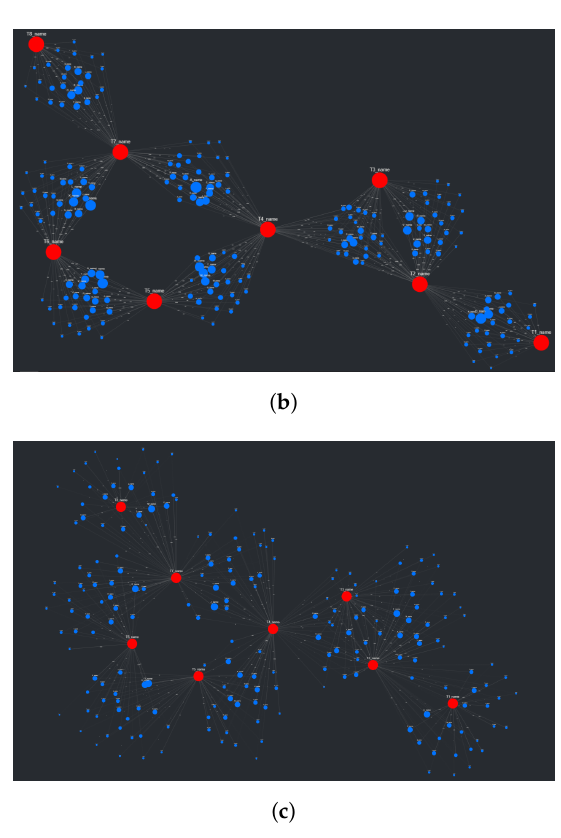
Figure 8. The impact of source spread ( k in the NetworkX spring layout). The data shown is placeholder data used in CompositeView. ( a ) Source spread value half of base. ( b ) Base source spread value, the same as Figure 5c. ( c ) Source spread value double of